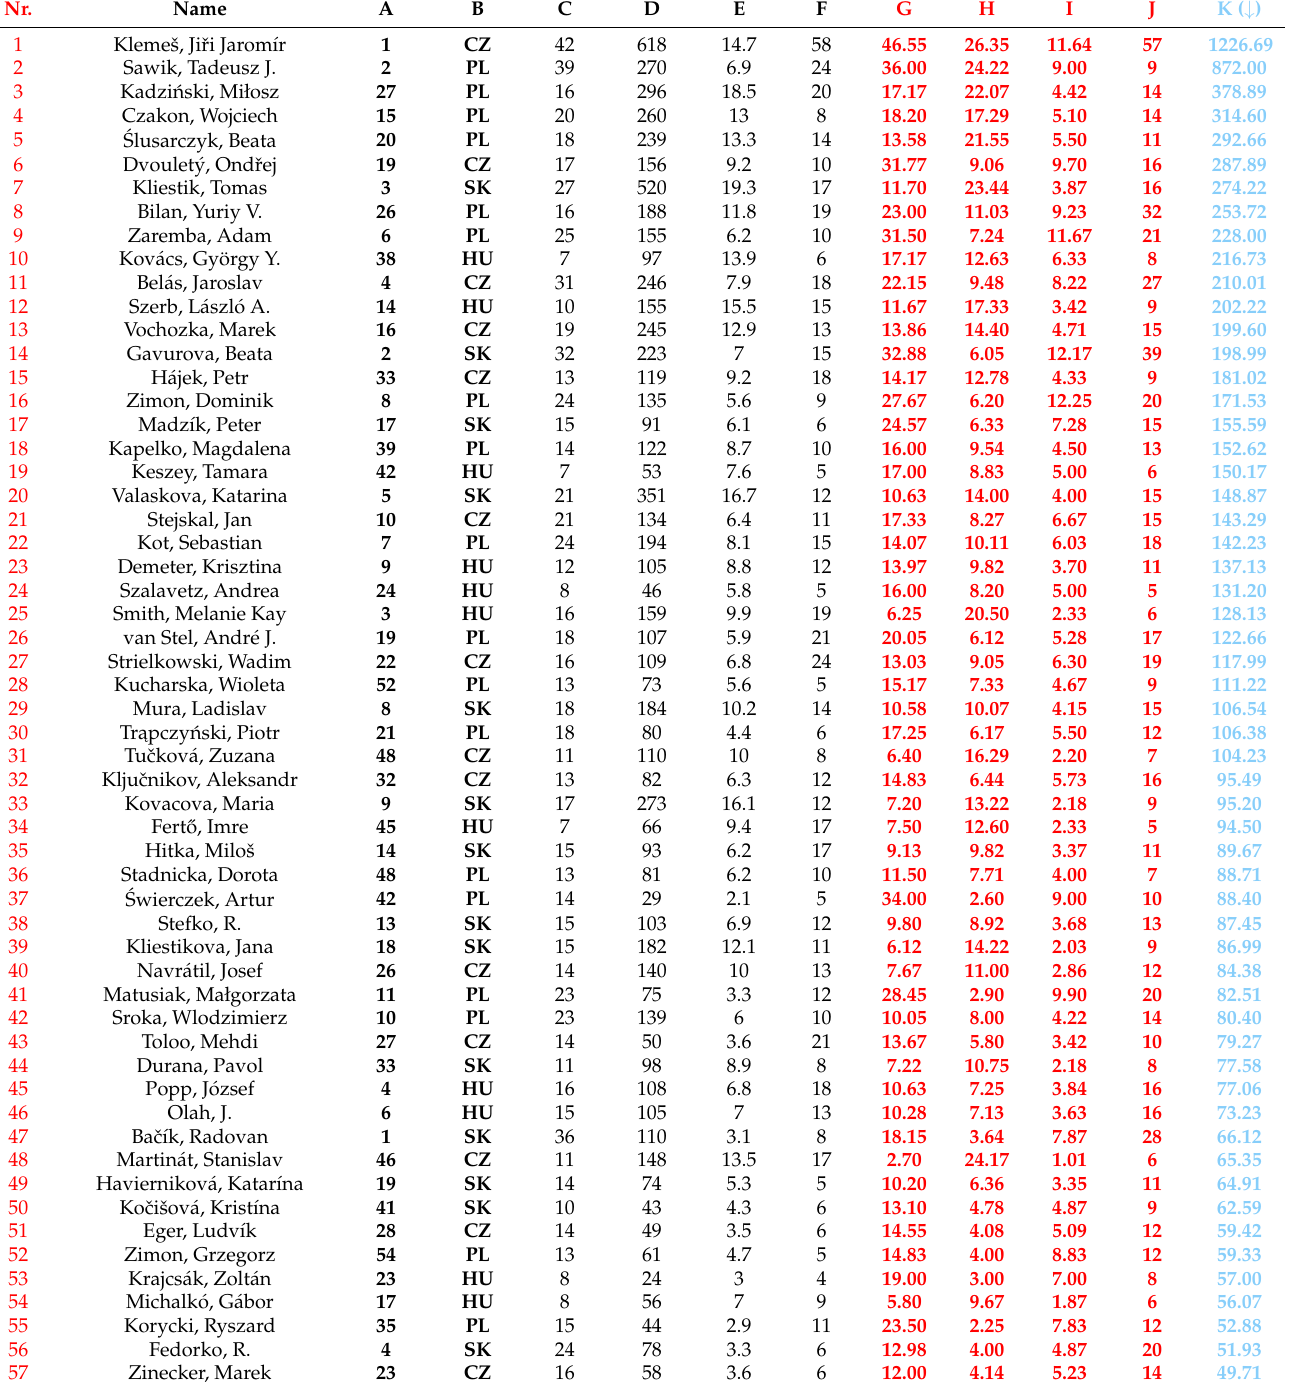
Table 1. Scientific metrics data for determining the individual publication performance of top 50 researchers in each Central European V4 country (in the period 2015–2020).